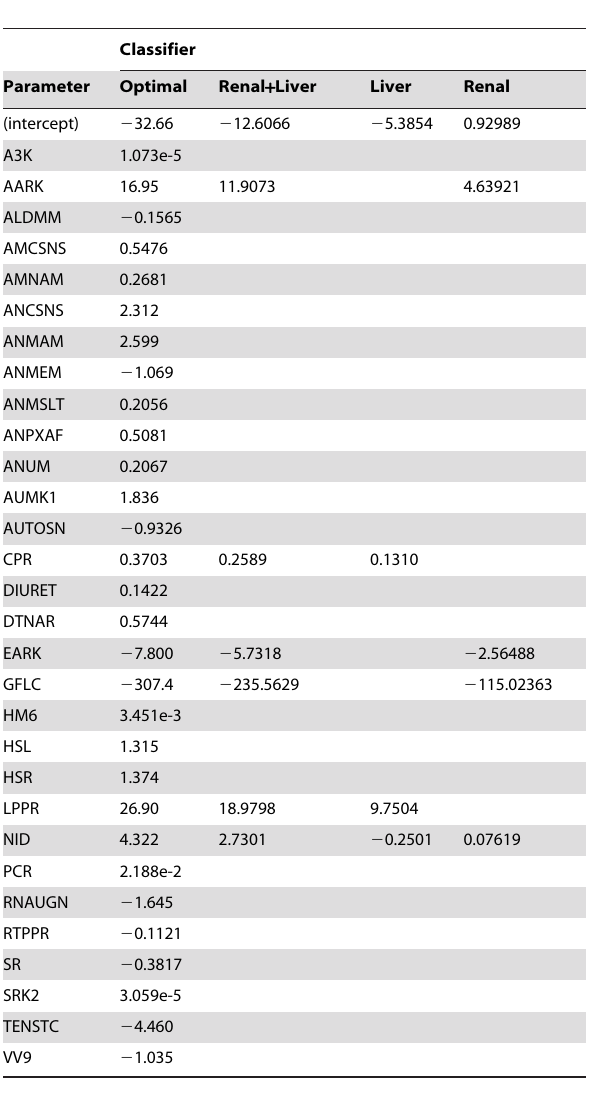
Table 5. The coefficients of each classifier (GLM) presented in Figure